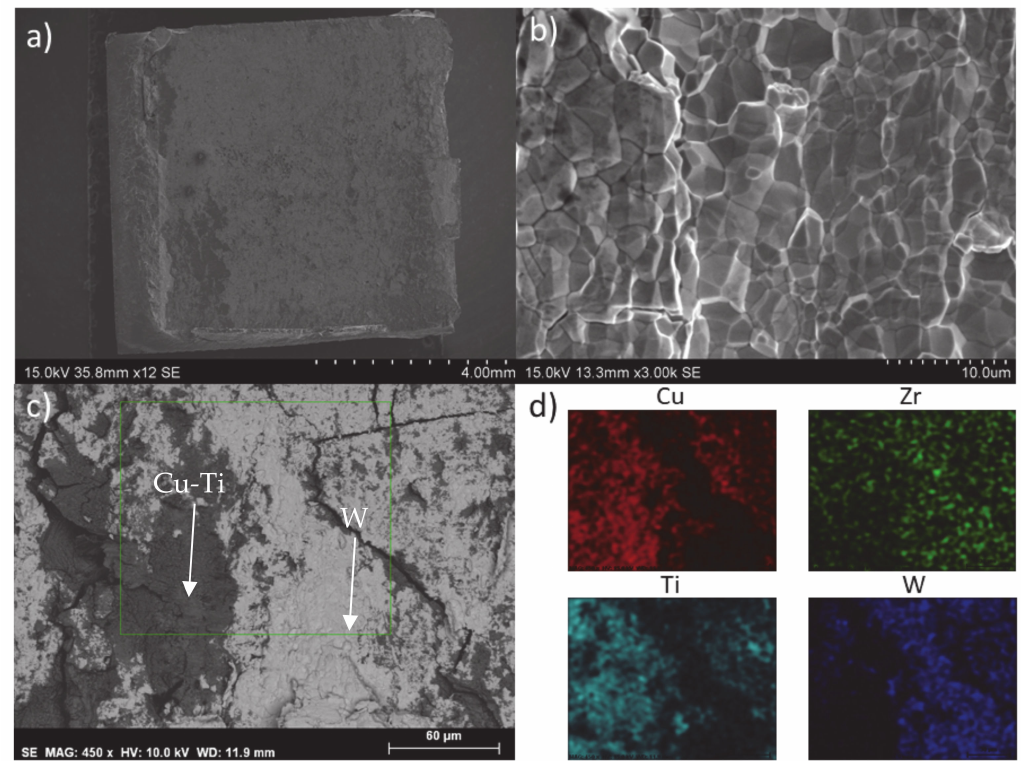
Figure 7. Fractographic images obtained by SEM of ( a ) CuCrZr and ( b ) tungsten side, ( c ) SEM-BSE image at the CuCrZr side, and ( d ) EDS elemental distribution map,